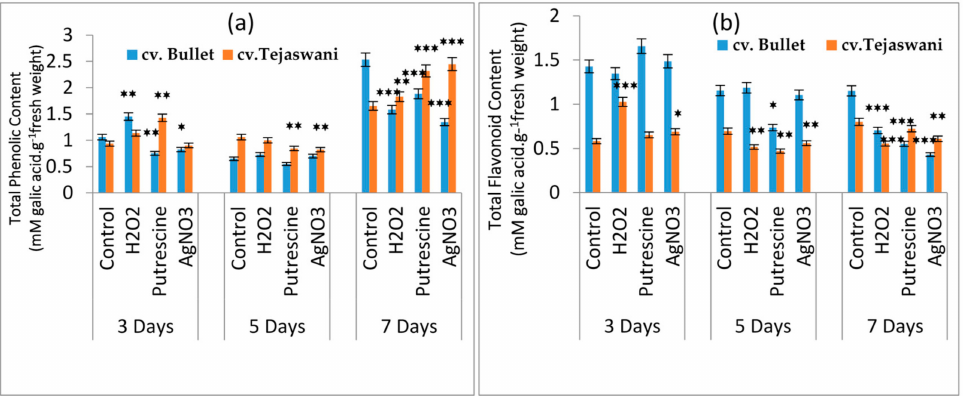
Figure 5. Changes of total phenolic content( a )and total flavonoid content ( b ) of two chili types, i.e., cv. Bullet and cv . Tejaswani, under di ff erent treatments (Control, H 2 O 2 , putrescine, and AgNO 3 ) and durations (3, 5, and 7 days). The vertical bars represent the data with the means of three replicates with ± SE ( n = 3) from an individual set of experiments, and significant di ff erences between treatments as calculated by a student’s t-test marked as * ( p ≤ 0.05) ** ( p ≤ 0.01) *** ( p ≤